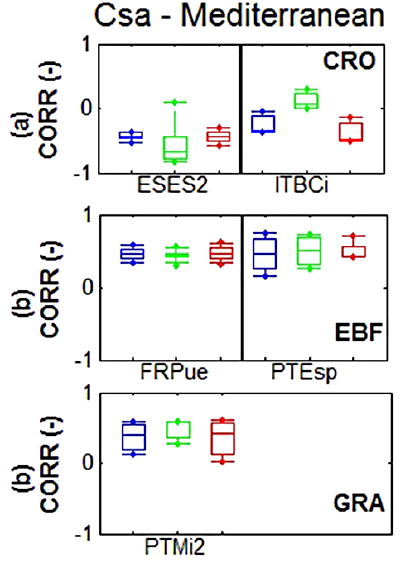
Figure 3. As in Fig. 2, except for the Csa Köppen’s climate class – temperate with dry summer and with hot